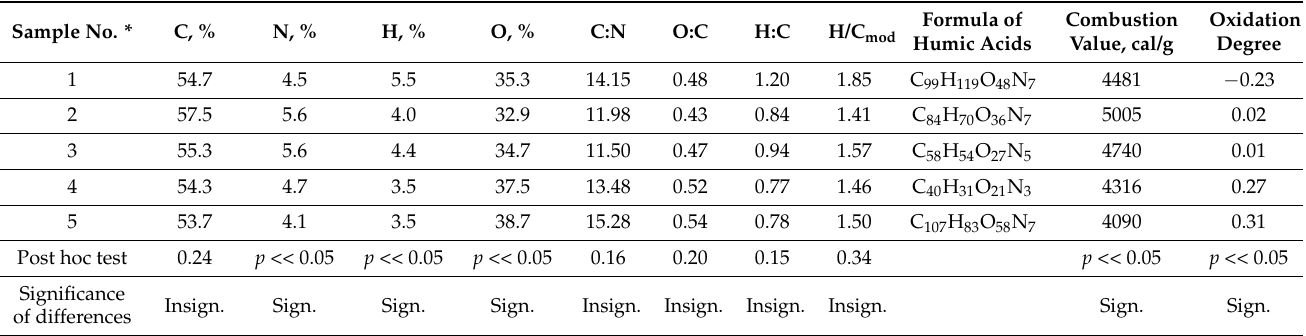
Table 3. The elemental composition of studied